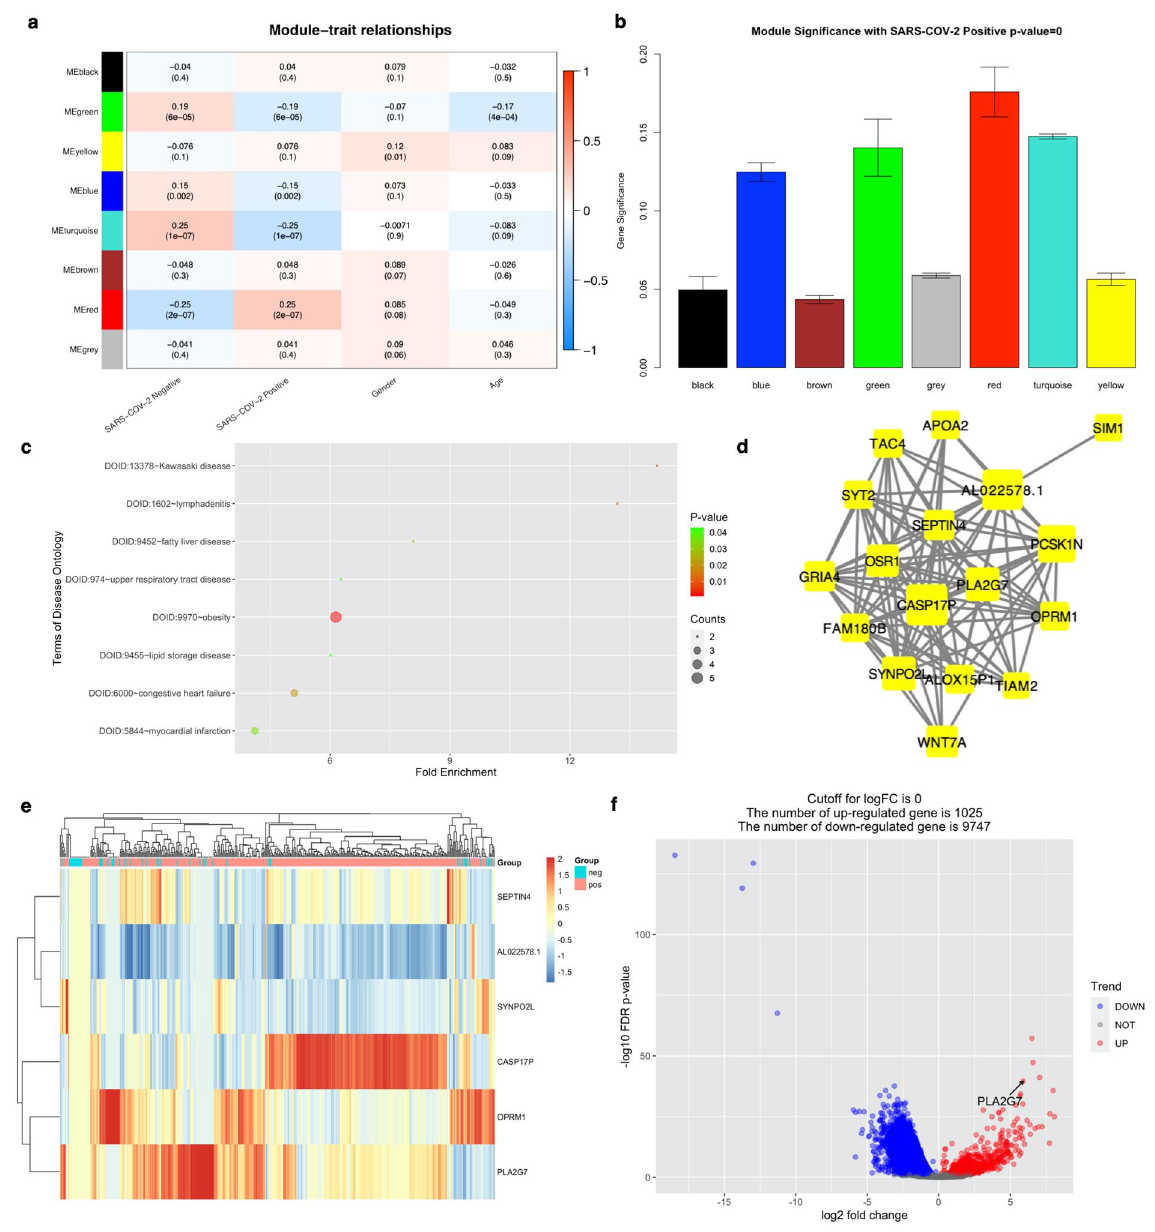
Figure 1. In silico discovery of PLA2G7 as the biomarker of SARS-CoV-2 infection. ( a ) Heatmap of the correlation between module eigengenes and the clinical traits recorded in GSE152075. ( b ) Distribution of average gene significance and errors in the modules associated with positivity of SARS-CoV-2. ( c ) Disease Ontology (DO) enrichment results on genes in red module. ( d ) Visualization of the network connections among the most connected genes in the red module. The size of circles was equal to the log2 fold change. ( e ) Heatmap based on unsupervised clustering of the selected 6 genes after scaling. Each row represented one gene; each column represents one patient. Expression intensity is indicated by color. ( f ) Volcano plot of differentially expressed genes (DEGs) for SARS-CoV-2 infection contrasting positive cases with negative ones in PLA2G7 was detected in a retrospective collection of nasal swabs from both COVID‑19 and pneumonia patients. In a total of 447 nasal swabs were collected and subject to SARS-CoV-2 targeted qRT-PCR. The 447 nasal swabs were grouped as: Health controls (n = 200), COVID-19 group (n = 134), Influ- enza infection (n = 52), Severe pneumonia (n = 41) and Moderate pneumonia (n = 20). It should be noted the median (interquartile range [IQR]) of Ct of COVID-19 group in present study were relatively higher than that in public dataset GSE152075 (SARS-CoV-2 Ct: 31.66 [28.62–34.00] vs. 21.31 [19.09–24.01]) (Fig. 3a). To match the records in GSE152075, the COVID-19 group were divided into two groups with Ct value ≤ 25 and > 25. Thereafter, we next explored the relationship between positive rates of PLA2G7 and viral load of SARS-CoV-2 in COVID- 19 group. The positive rates of PLA2G7 were correlated with Ct of SARS-CoV-2 (r = − 0.96, P value = 3.3e − 12)